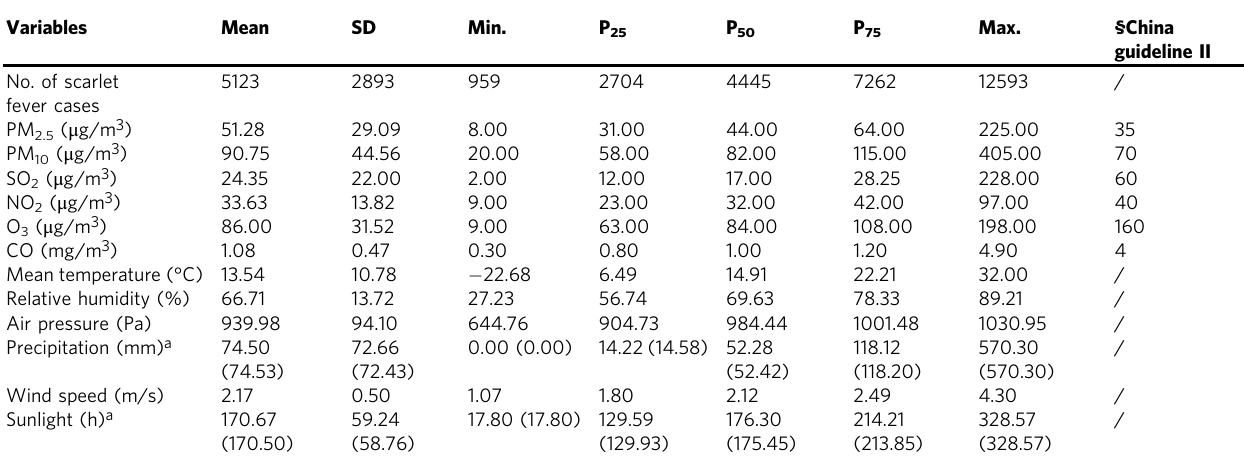
Table 1 Descriptive statistics for monthly scarlet fever cases and air pollution concentrations, and weather conditions in China, 2013 – 2018 ( n =